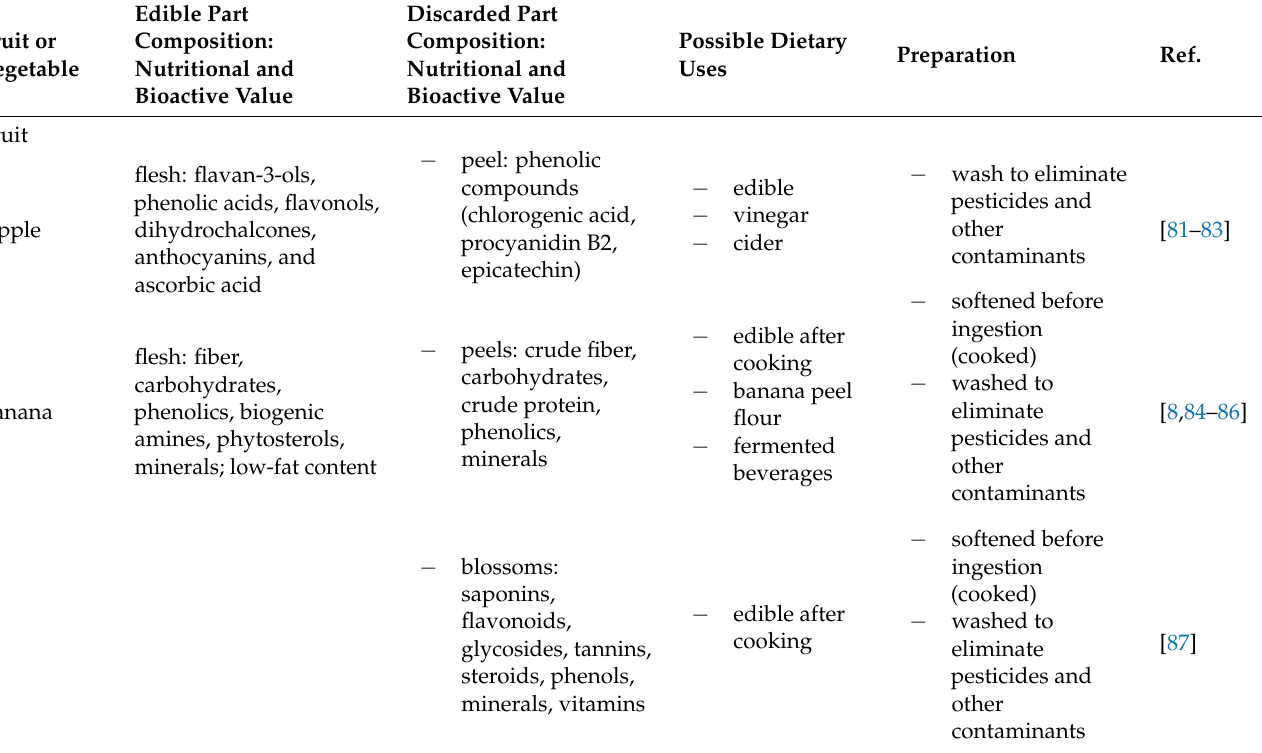
Table 1. Main fruits and vegetables consumed worldwide with a rich bioactive waste